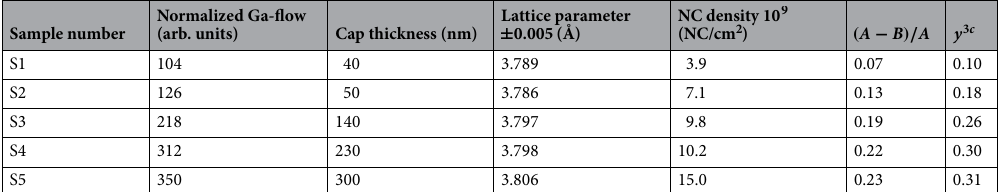
Table 1. Investigated samples: growth parameters, lattice parameter along the c -growth direction calculated from HRXRD, NCs density 8 , and fit parameters extracted from DAFS.